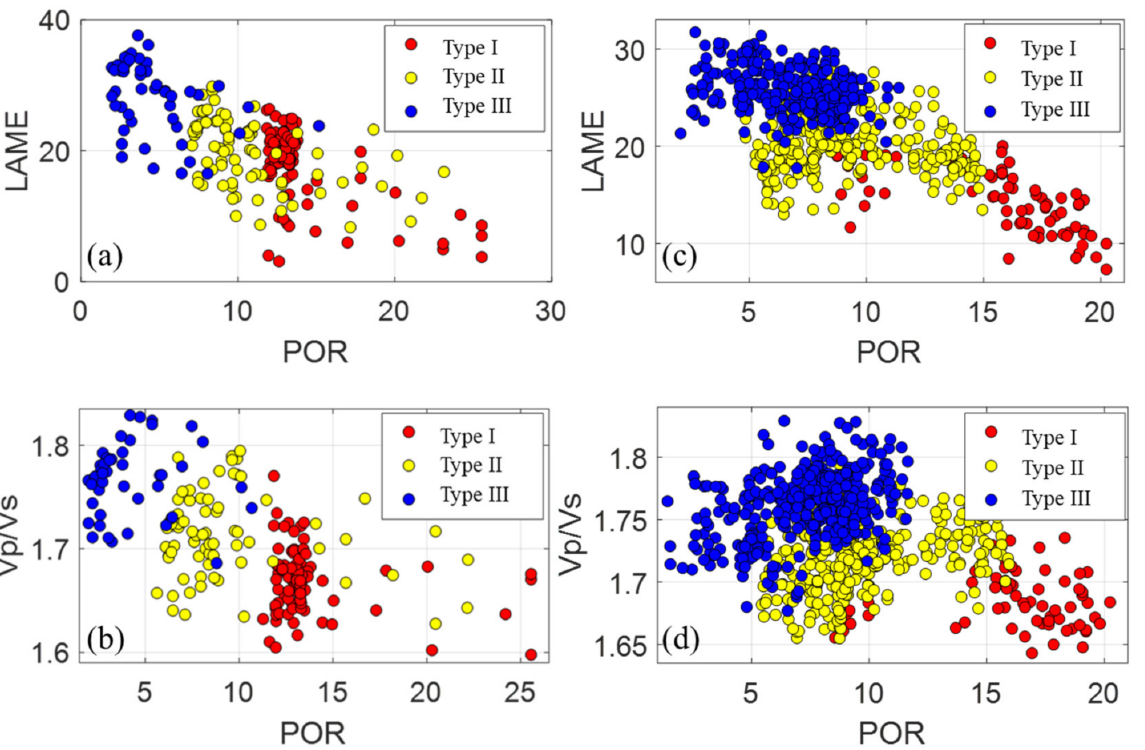
Figure 5. ( a ) The intersection of the Lame coefficient and porosity of the G1 layer, ( b ) the intersection of V p / V s and porosity of the G1 layer, ( c ) the intersection of the Lame coefficient and porosity of the G2 layer and ( d ) the intersection of V p / V s and porosity of the G2 layer. Combining the P-wave, S-wave and density log data of the wells in the study area allows for the construction of a low-frequency model. The initial low-frequency model of the prestack three-parameter inversion established by the seismic data is shown in Figure 6. The initial model established by this method varies in different target intervals. The corresponding low-frequency initial models are different, with highly apparent lateral variation